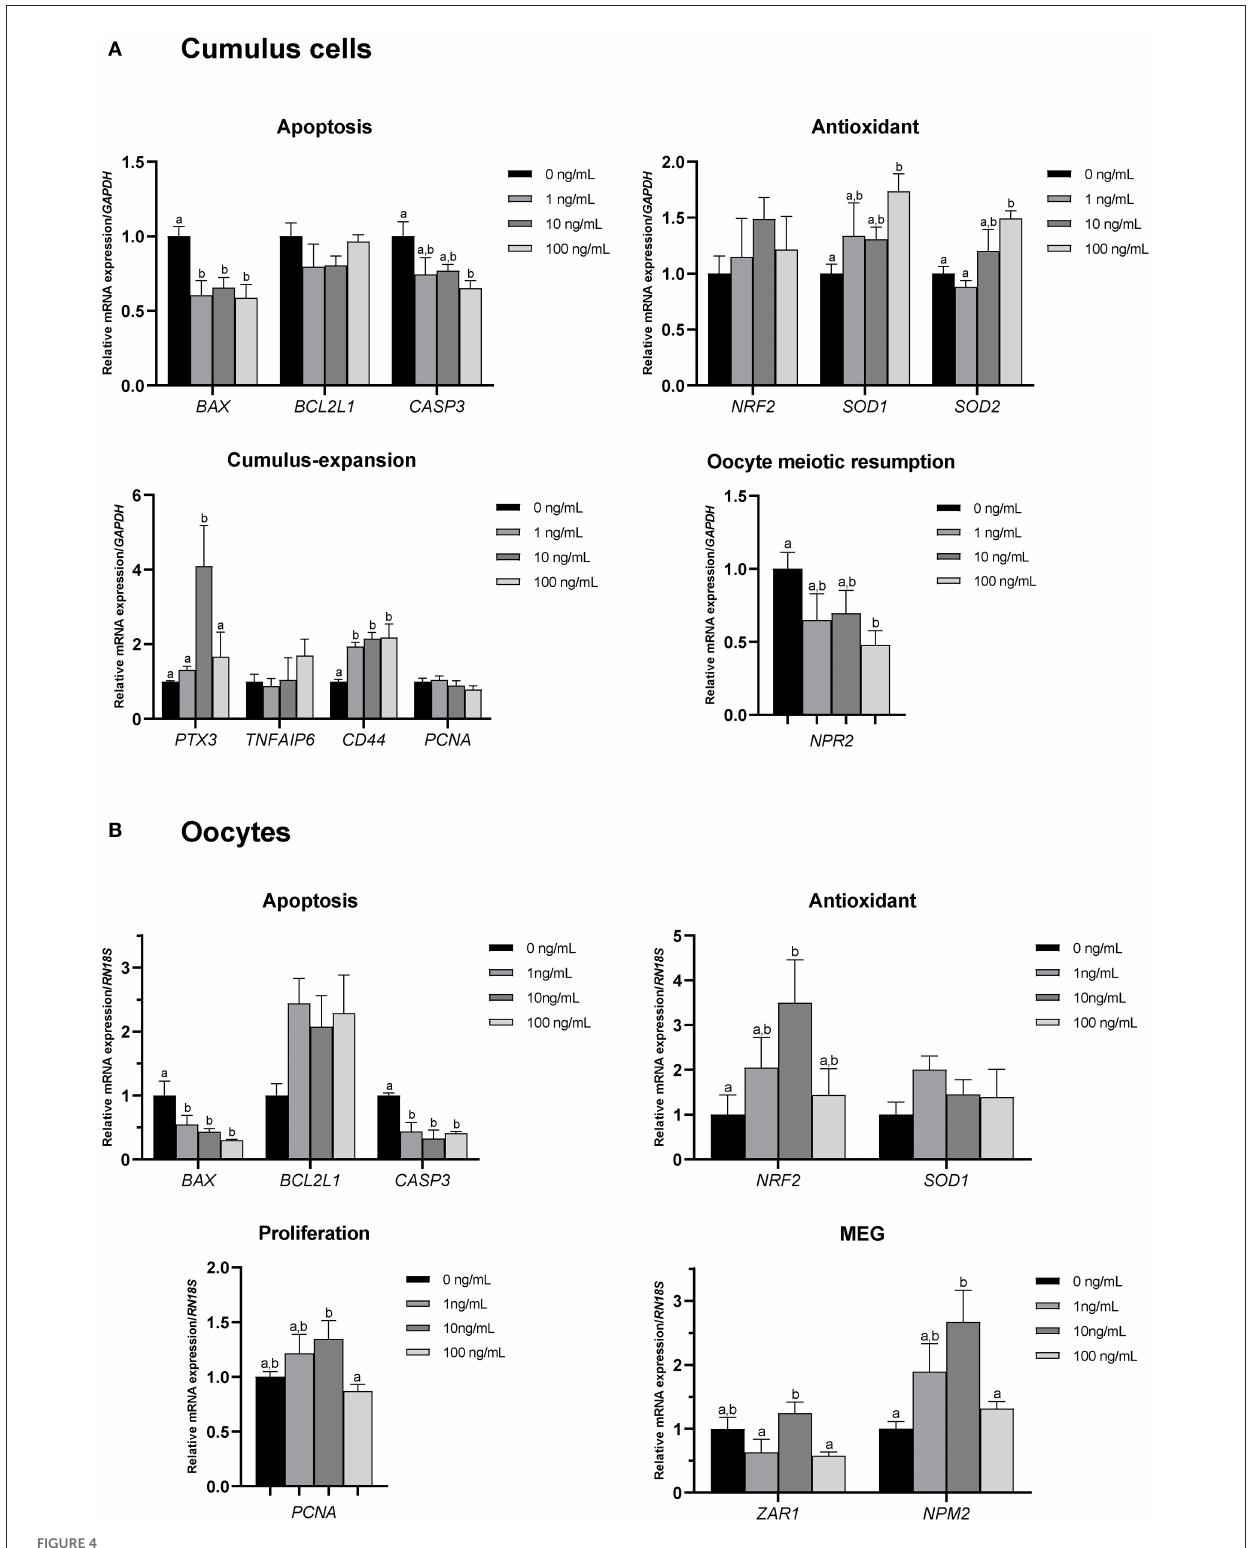
FIGURE4 mRNA levels of apoptosis-, antioxidant-, cumulus expansion/proliferation-, and oocyte meiotic resumption-related genes and maternal-effect genes (MEGs). Levels of BAX, BCL2L1, CASP3, NRF2, SOD1, SOD2, PTX3, TNFAIP6, CD44, PCNA , and NPR2 were assessed in groups of CCs (A) , and levels of BAX, BCL2L1, CASP3, NRF2, SOD1, PCNA, ZAR1 , and NPM2 were assessed in groups of oocytes (B) supplemented with 0, 1, 10, and 100ng/mL of CCL2 during IVM. Data is represented as mean ± SEM. The experiment was replicated at least three times. Bars with different letters (a, b) are significantly different ( p <